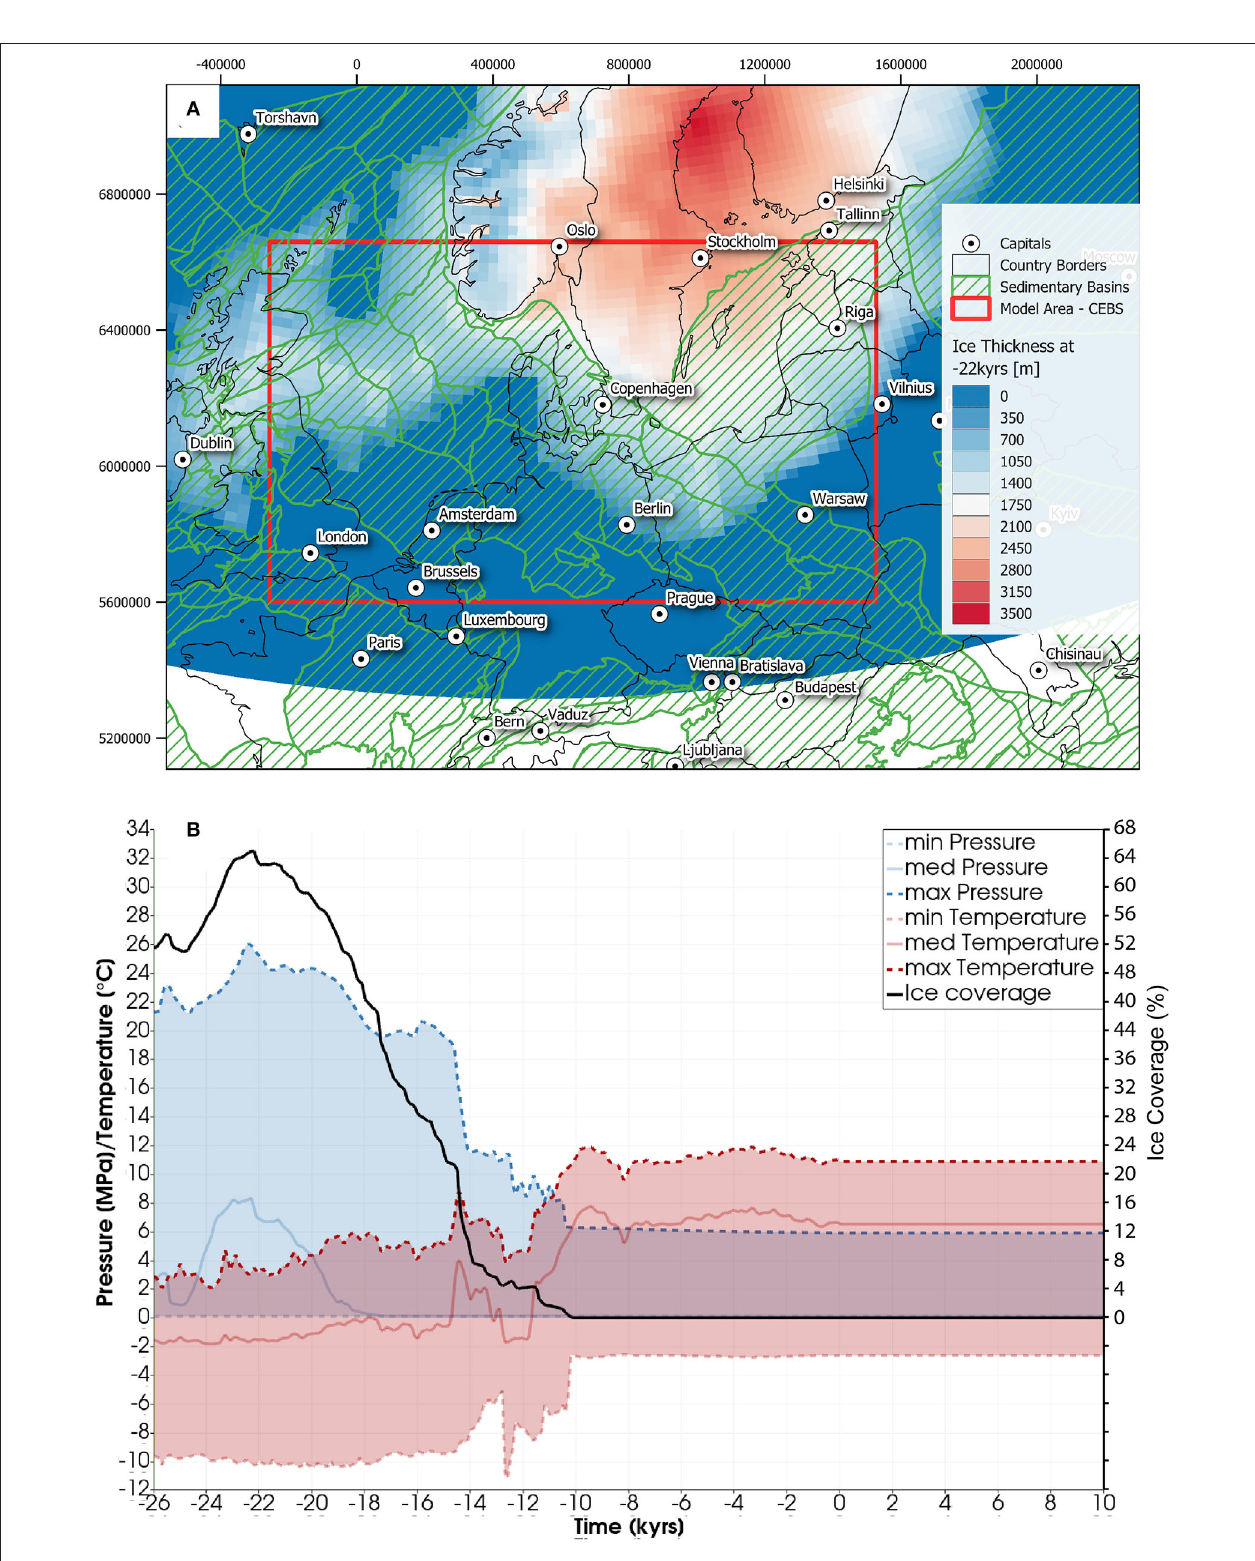
FIGURE 2 | Input and output data used to represent the time varying boundary conditions at the topmost surface of the model. (A) Extent of the modeled ice thickness (0.5 degrees resolution) at − 26 kyrs after Tarasov et al. (2014). The red square outlines our model area extent. The cross hatched green areas highlight